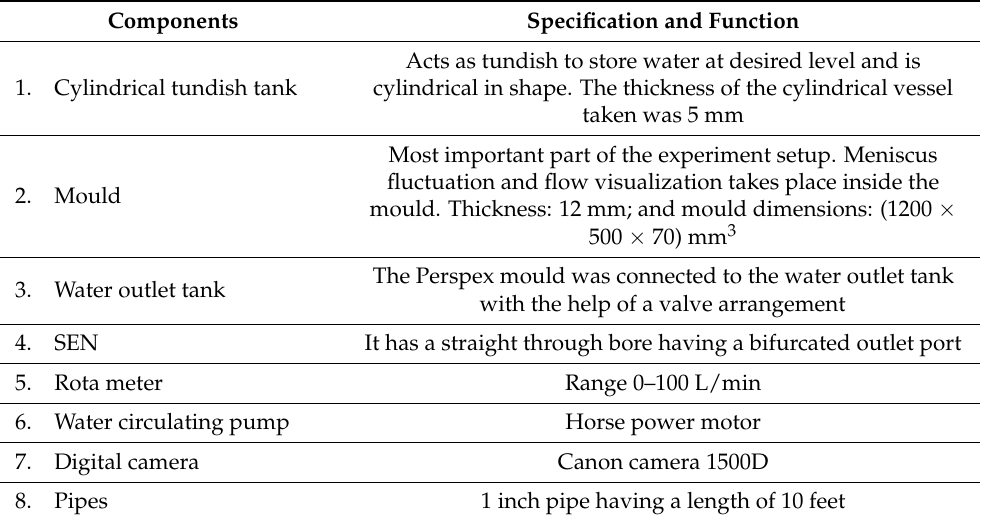
Table 3. The components and specification of the experimental setup are as